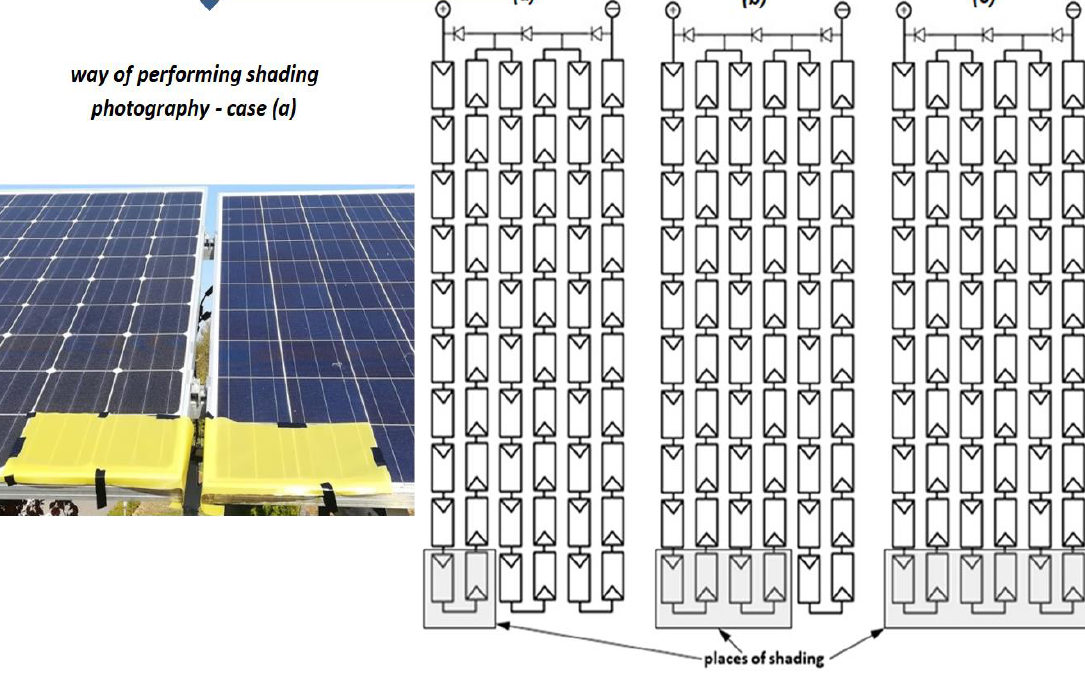
Table 1. Selected technical data of the PV modules according to the manufacturers.